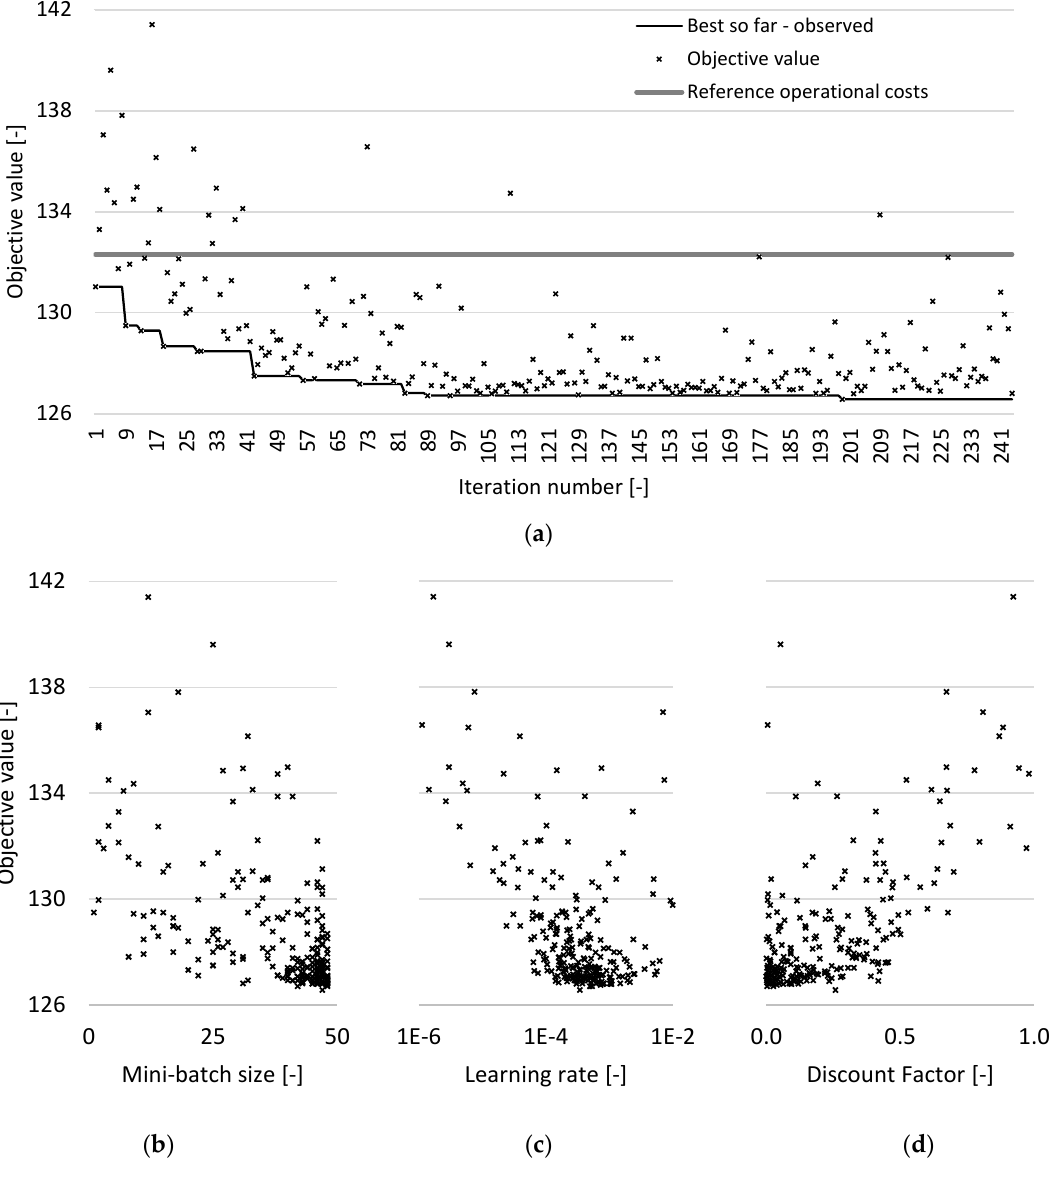
Figure 6. Results of the Bayesian optimization—Objective values over all iteration steps ( a ), effect of mini-batch size on objective value ( b ), effect of learning rate on objective value ( c ), and effect of discount factor on objective value ( d ).